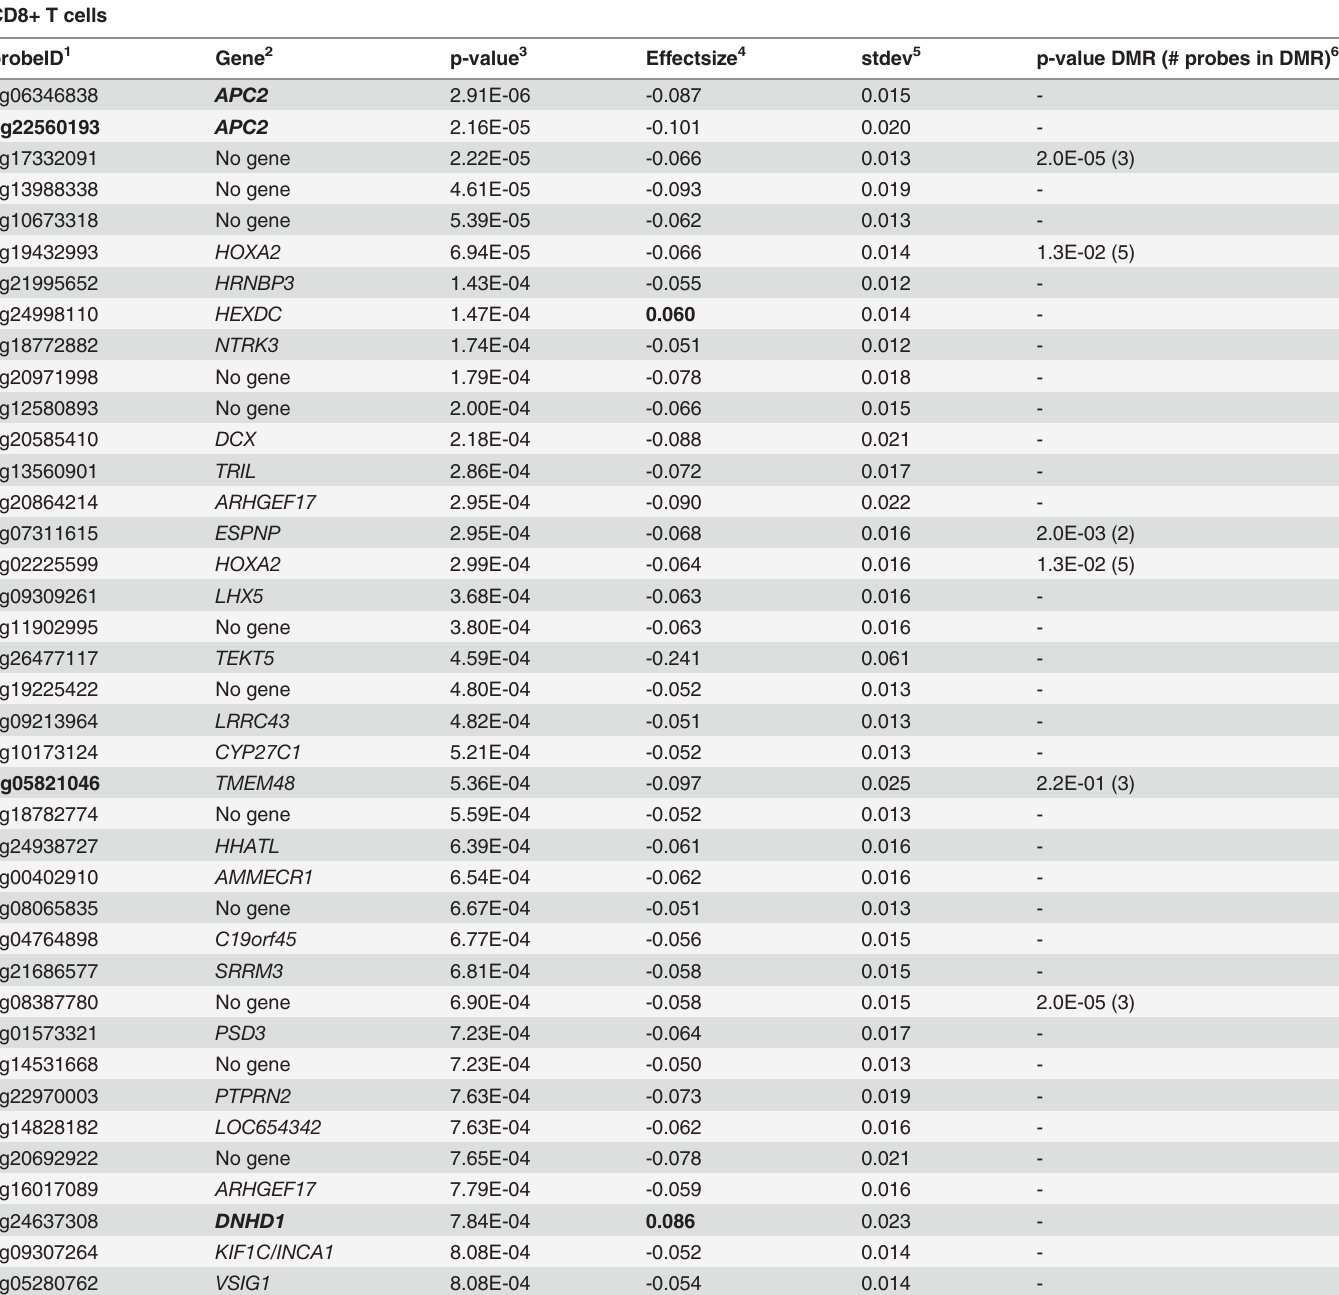
Table 3. Top 40 results sorted by p-values from linear regression analysis models of DNA methylation in CD8+ T cells. CD8+ T